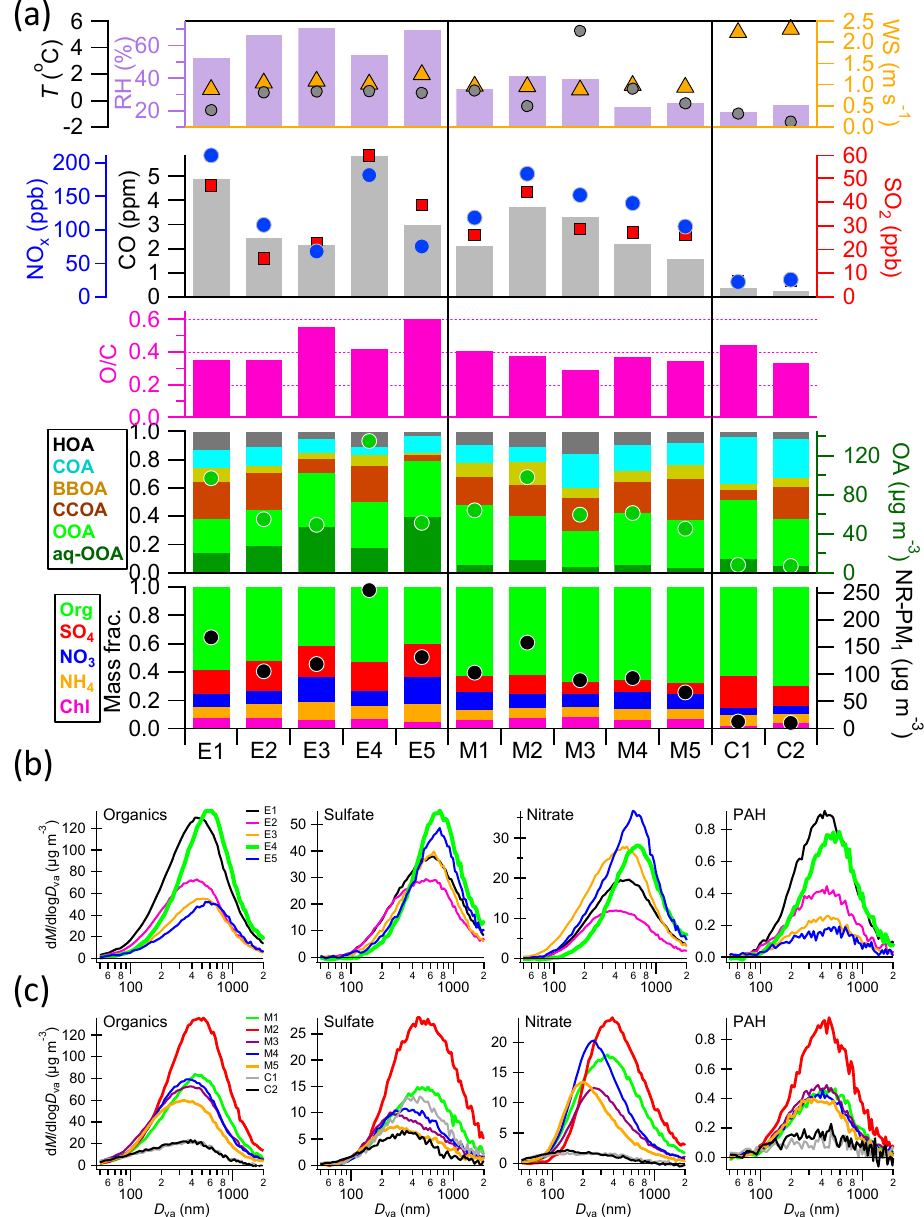
Figure 12. Summary of (a) meteorological conditions, gaseous species, O / C, OA composition and NR-PM 1 composition, and size distri- butions of organics, sulfate, nitrate and chloride for episodes (b) E1–E5 and (c) M1–M5 and C1–C2 in Fig. 1.